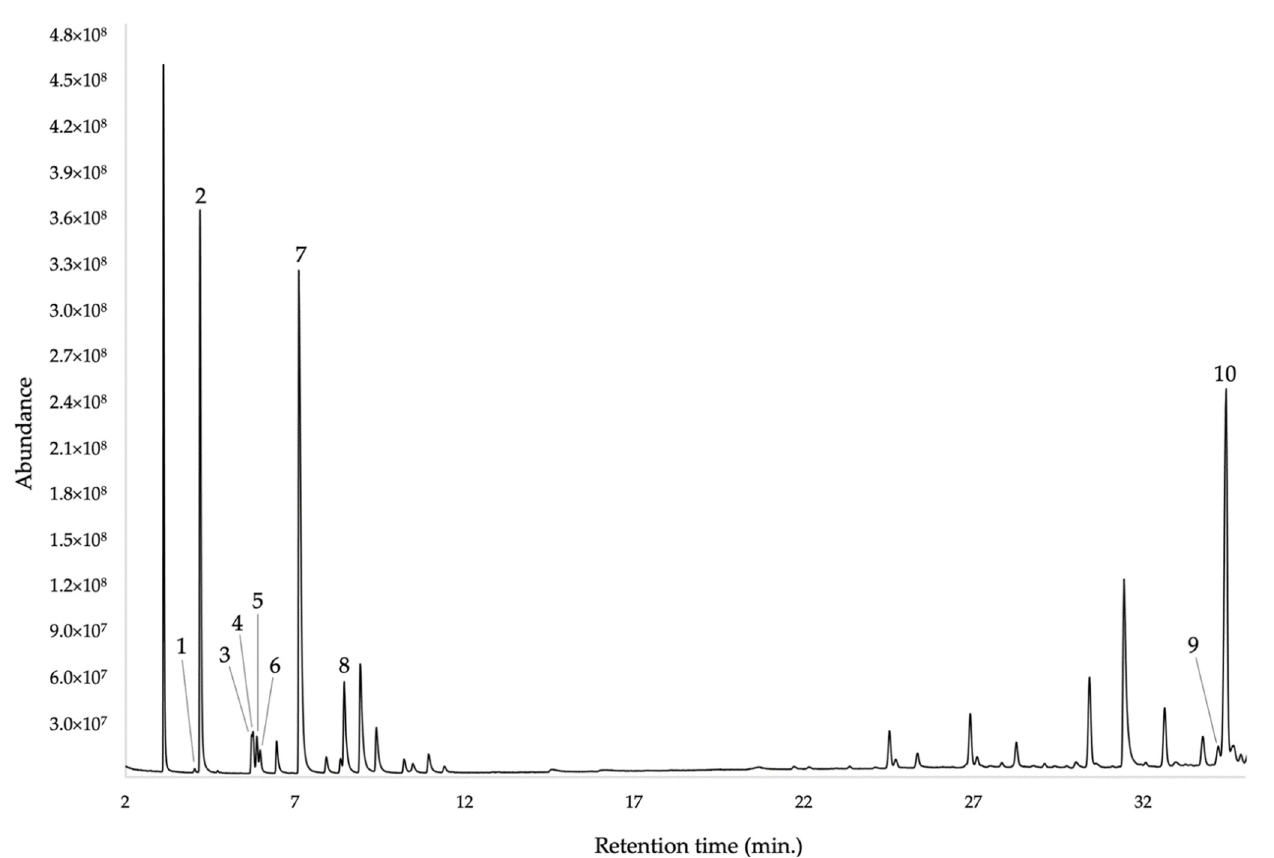
Figure 3. GC-MS chromatogram of G. miniphylla EO obtained with a 2,3-diethyl-6- tert -butyldimethylsilyl- β -cyclodextrin capillary column. 1: (1 R ,5 R )-(+)- α -pinene; 2: (1 S ,5 S )-( − )- α -pinene; 3: (1 R ,5 R )-(+)- β -pinene; 4: (1 S ,5 S )-(-)- β -pinene; 5: (1 R ,5 R )-(+)-sabinene; 6: (1 S ,5 S )-( − )-sabinene; 7: ( R )-(-)- α -phellandrene; 8: ( R )-(-)- β -phellandrene; 9: ( R )-(+)-germacrene D; 10: ( S )-( − )-germacrene D.